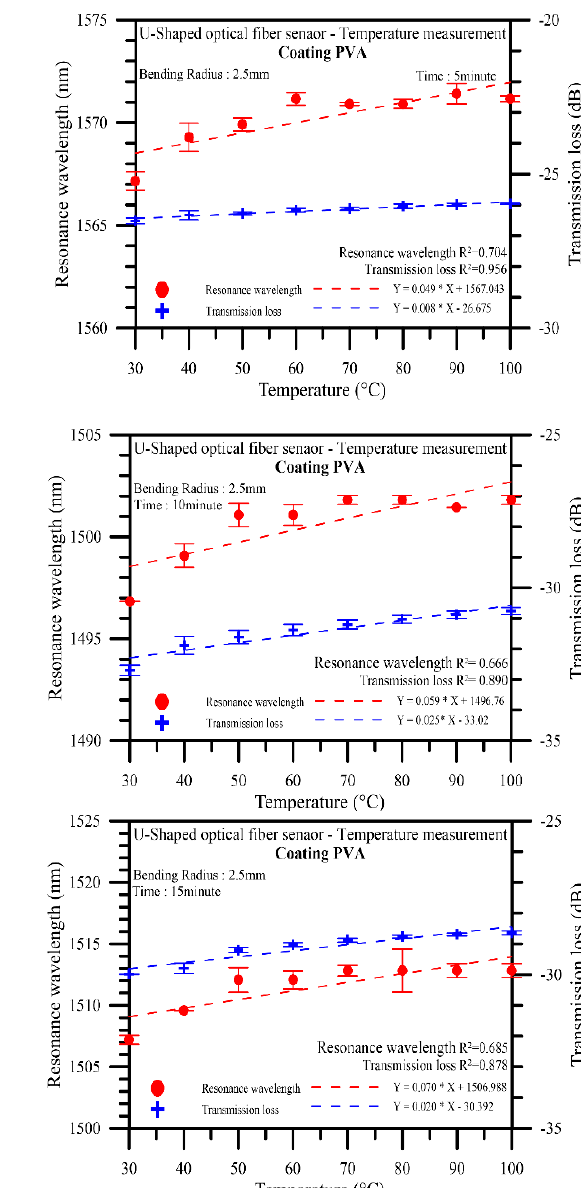
Figure 10. Electrospinning duration–sensitivity relation graph. 5. Conclusions This sensor in varying temperatures via U-shaped optical fiber was performed through an electrospun nanofibers process. The unique structure and properties of elec- trospun nanofiber materials are provided through PVA polymer, and the spectrum sim-